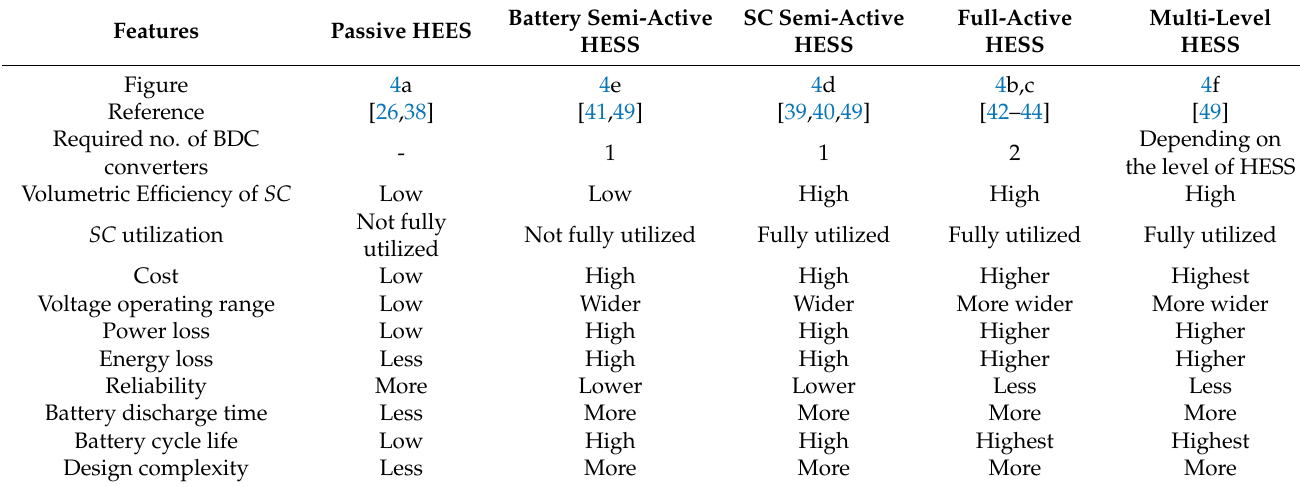
Table 1. Features of various HESS